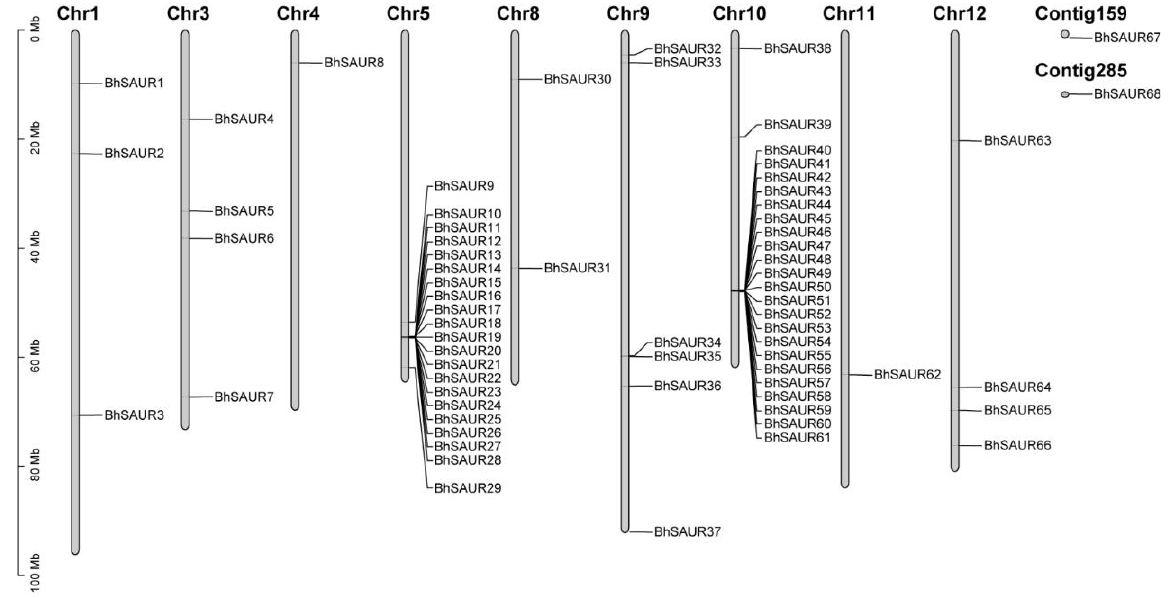
Figure 1. Chromosomal location of the BhSAUR genes.